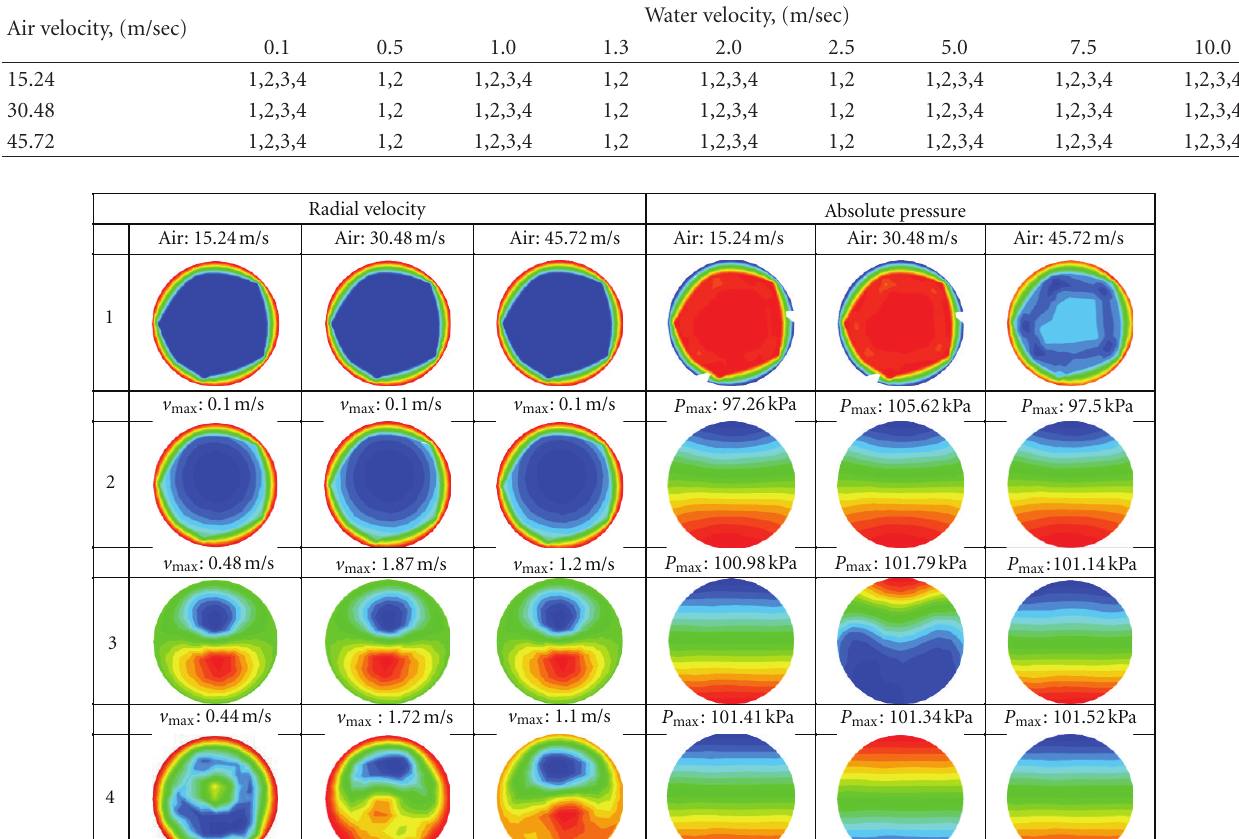
Table 3: Flow conditions used in CFD analysis.